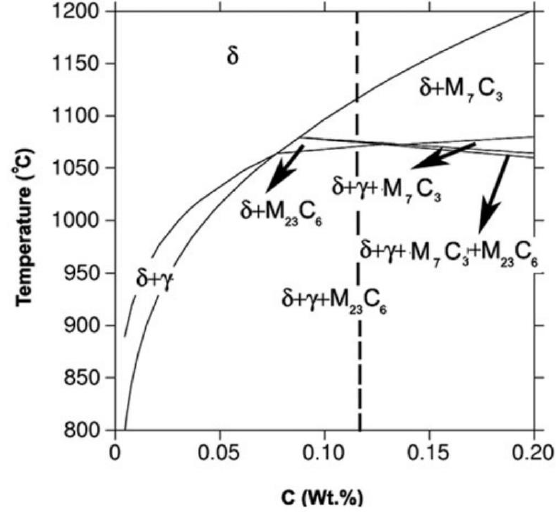
Figure 16. The equilibrium phase diagram of SS410 material obtained with the aid of Thermocalc software to predict the phases formed in the microstructure [51].